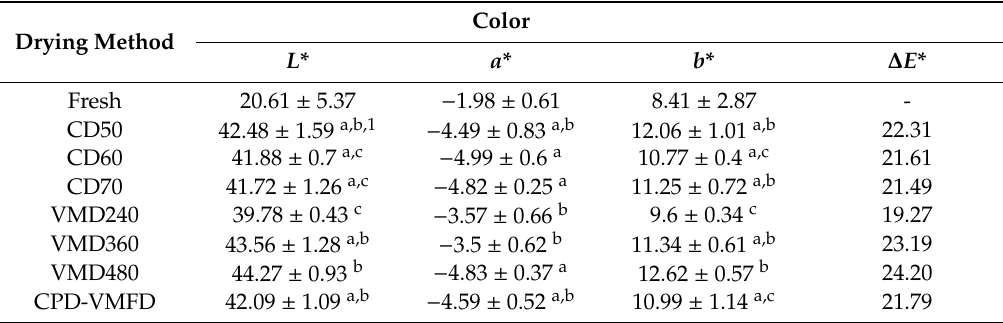
Table 2. Color parameters of hemp flowers subjected to drying using di ff erent methods. Drying